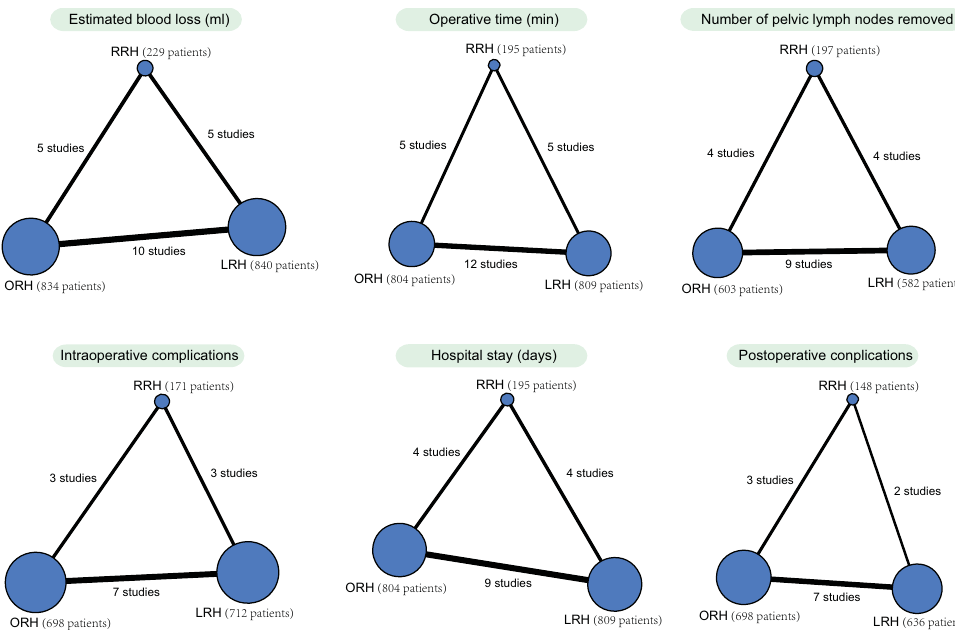
Fig 2. Network evidence plots of estimated blood loss (ml), operative time (min), number of pelvic lymph nodes removed, intraoperative complications, hospital stay (days) and postoperative complications of RRH, LRH and ORH in the treatment of early-stage CC. Note: RRH, robotic radical hysterectomy; LRH, laparoscopic radical hysterectomy; ORH, open radical hysterectomy; CC cervical cancer. https://doi.org/10.1371/journal.pone.0193033.g002 SUCRA values of estimated blood loss (ml), operative time (min), number of pelvic lymph nodes removed, intraoperative complications, hospital stay (days) and postoperative complications (96.67%, 82.67%, 90.67%, 82.33%, 86.33%, and 98.33%). ORH demonstrated the lowest SUCRA values of estimated blood loss (ml), operative time (min), number of pelvic lymph nodes removed, hospital stay (days) and postoperative complications (33.33%, 43.67%, 43.33%, 33.33%, and 35.00%). LRH demonstrated the lowest SUCRA value of intraoperative complications (55.33%). In conclusion, patients receiving RRH proved less estimated blood loss (ml), short operative time